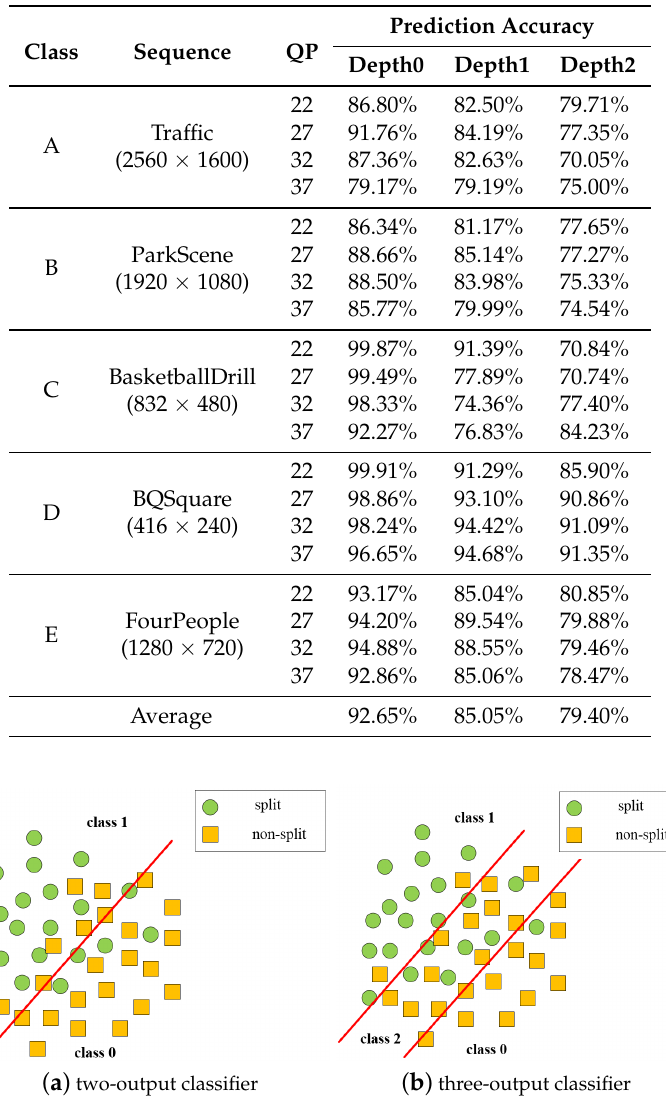
Table 2. prediction accuracy of CUs in different depth.